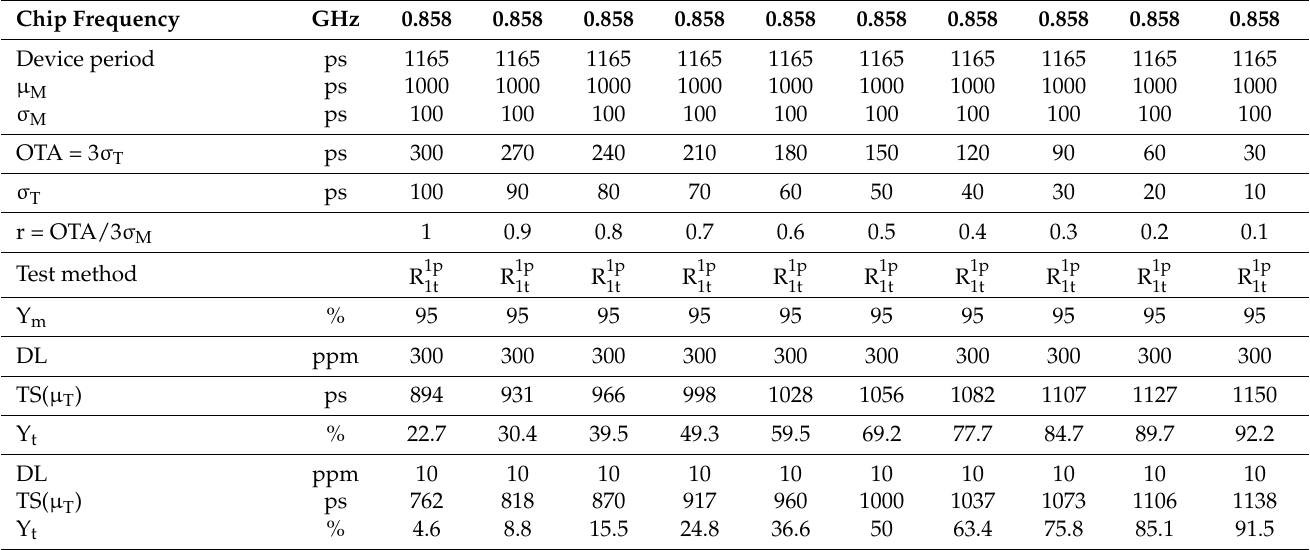
Figure 5. High-precision ATE can increase test yield and chips shipments. Table 1. Test accuracy impacts test yield and test